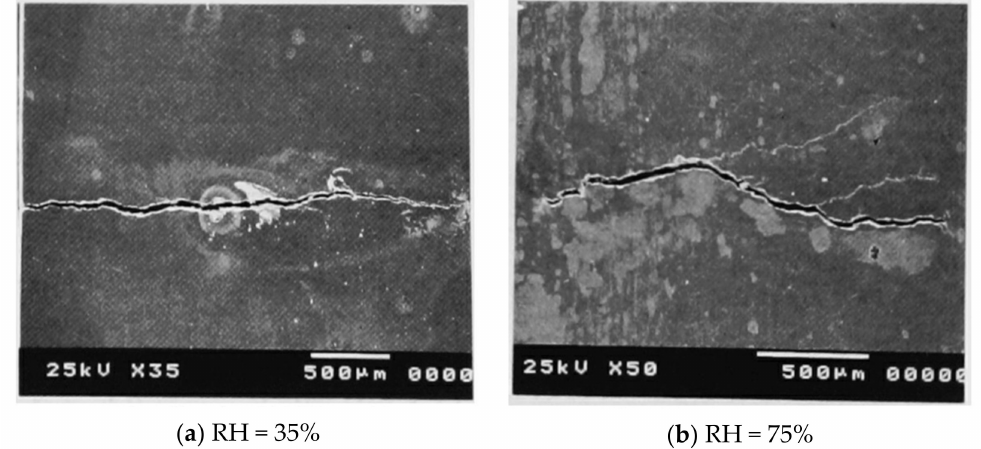
Figure 5. SEM image of the sample surface.